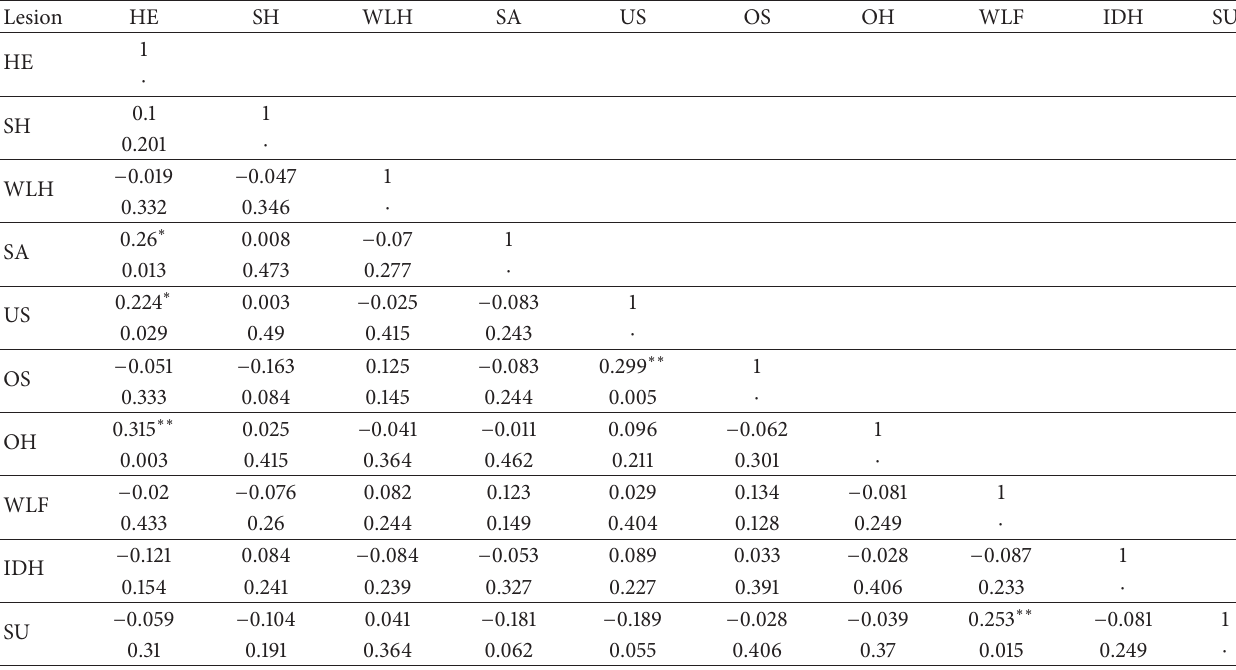
∗ Significant at 0.05 level; ∗∗ significant at 0.01 level.